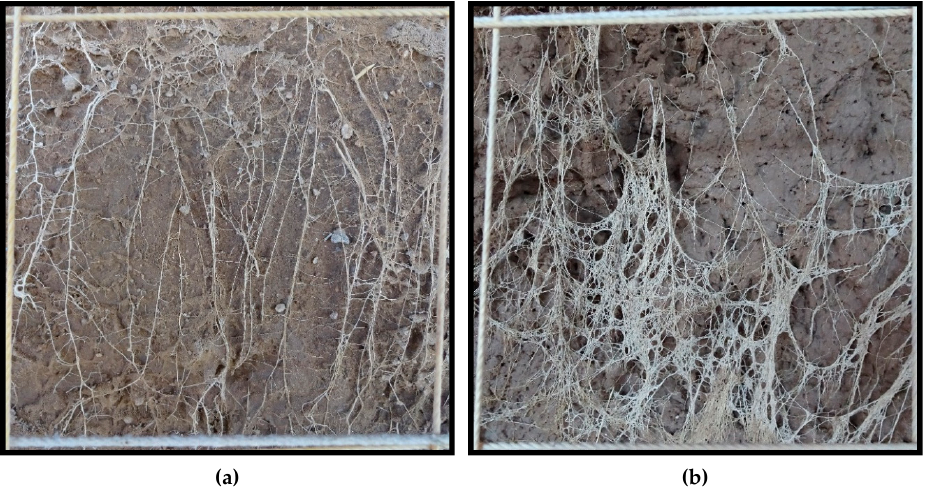
Figure 5. Root profile at physiological maturity (PM) from 50–10 cm under low irrigation treatment in 2018, red line indicates start of caliche layer at 70 cm: ( a ) “Solar” variety at PM with roots growing through caliche; ( b ) “Cochise” variety at PM showing root growth stops at the caliche layer.